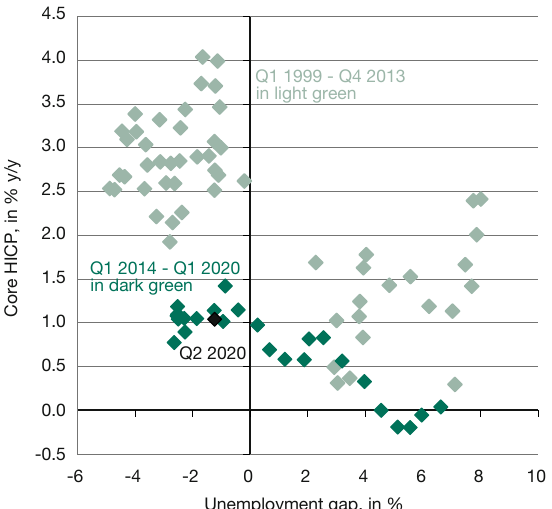
Italy: Phillips curve since 1999 using European Commission estimates for the unemployment gap